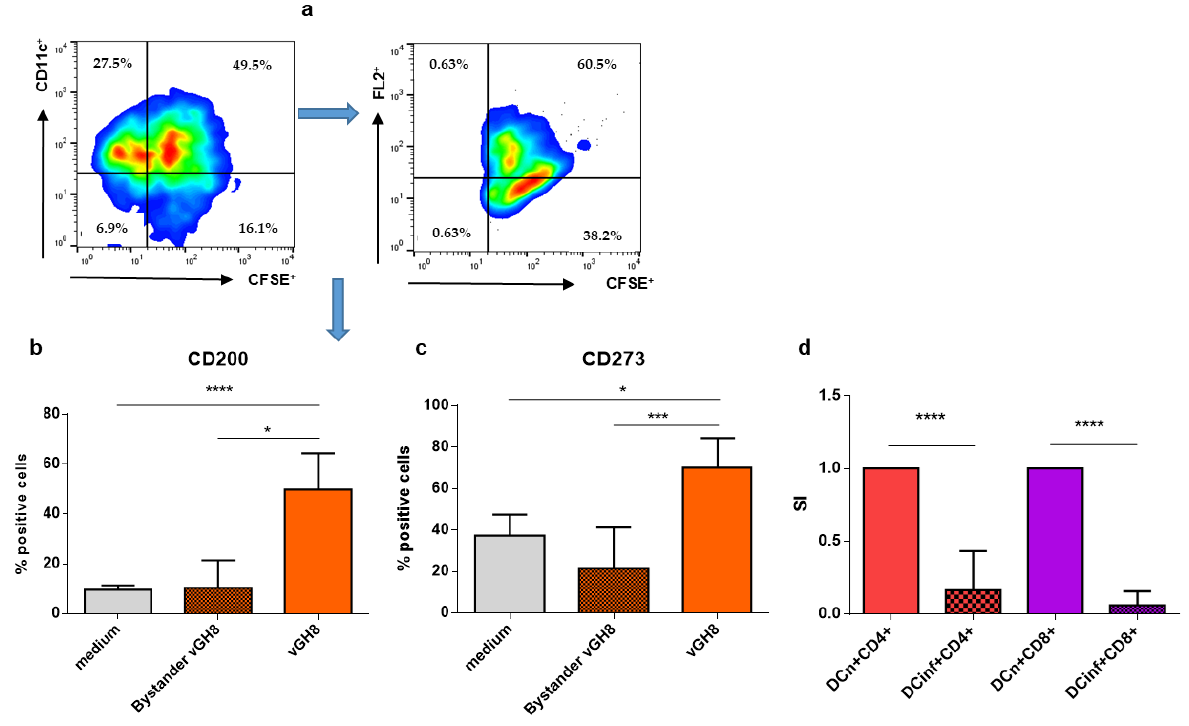
Figure 5. Effect of L. infantum infection of BMDCs on the expression of immune checkpoint molecules and on T cell proliferation/activation: ( a ) Representative dot plots of the gating strategy to isolate/discriminate CD200 and CD273 (PD-L2) expressing parasite-infected BMDCs from by-stander BMDCs. ( b ) CD200 and ( c ) CD273 molecules were detected in bystander and L. infantum -infected BMDCs by flow cytometry. ( d ) BMDCs exposed to L. infantum were co-cultured with CD4 + or CD8 + T cells isolated from spleen obtained from a naïve mouse for 96 h. The final 18 h, cultures were pulsed with 0.5 µCi of [ 3 H]-TdR. The mean ± SD of three independent experiments is shown (*: p < 0.05, ***: p < 0.001, ****: p < 0.0001).